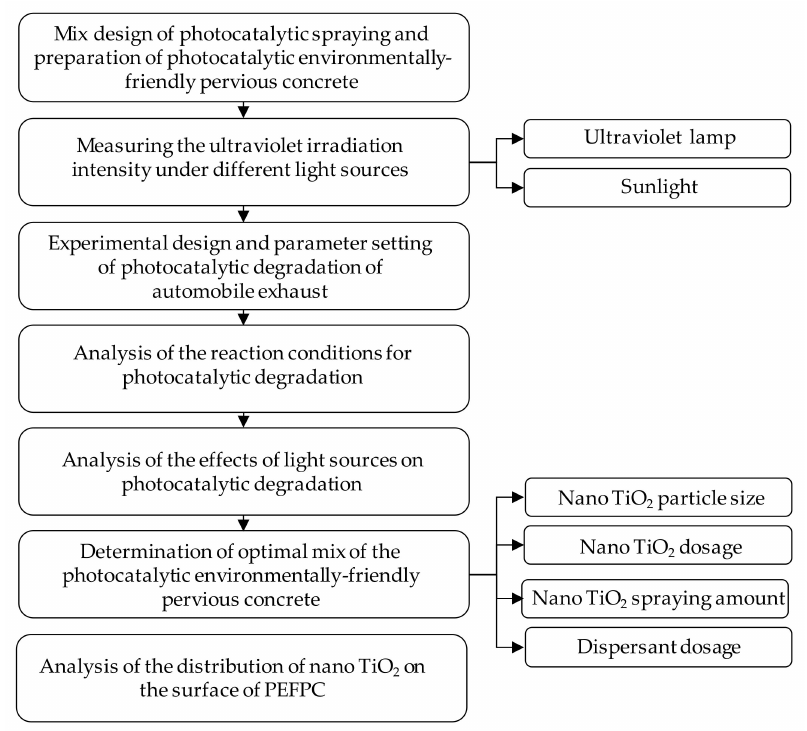
Figure 1. Research